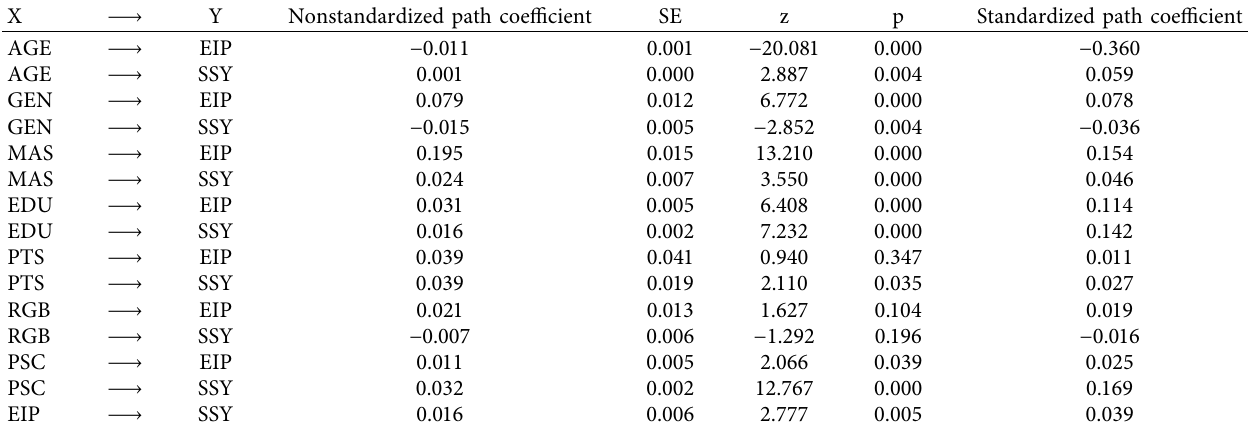
Table 2: Estimated results of the impact of endowment insurance on the sense of security (city).